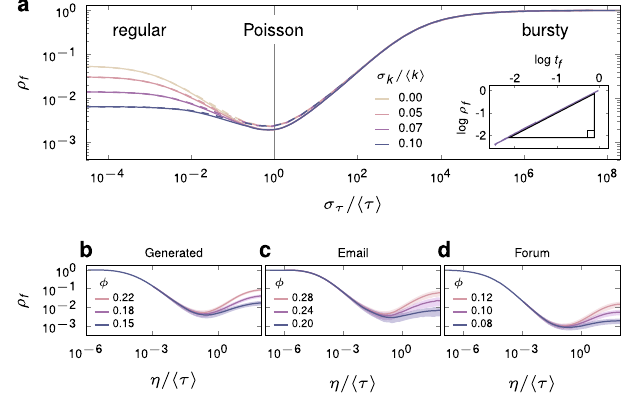
Fig. 2 Fraction of infections due to noise, ρ f , as a function of interevent time distribution. Normalised diffusion time t f produces an almost identical effect (see a , inset). The small σ τ limit, leading to regular patterns in τ , comprises the quenched limit in a where η = 1 and the network is effectively static. The large σ τ limit produces large bursts in activity, comprising the annealed regime where the network is effectively sparsi fi ed and plays no role in information diffusion ( ρ f = 1). Mirroring results are achieved by varying memory η for fi xed σ τ in generated, b , and empirical, c – d , temporal networks. Analytic solution is denoted by dashed lines, and Monte Carlo results by solid lines. Generated networks have lognormal degree distribution with mean 〈 k 〉 = 7 and standard deviation σ k = 2. We use Weibull-distributed interevent times with mean 〈 τ 〉 = 1. Plot b uses σ τ = 1. For empirical data description see Methods. Node dynamics correspond to the RT model with threshold ϕ = 0.15 and external noise p = 2 × 10 − 4 . Cutoff density is ρ c = 0.4. Monte Carlo simulations are averaged over 10 4 realisations. Network size is 10 6 in a , and 5 × 10 3 in b